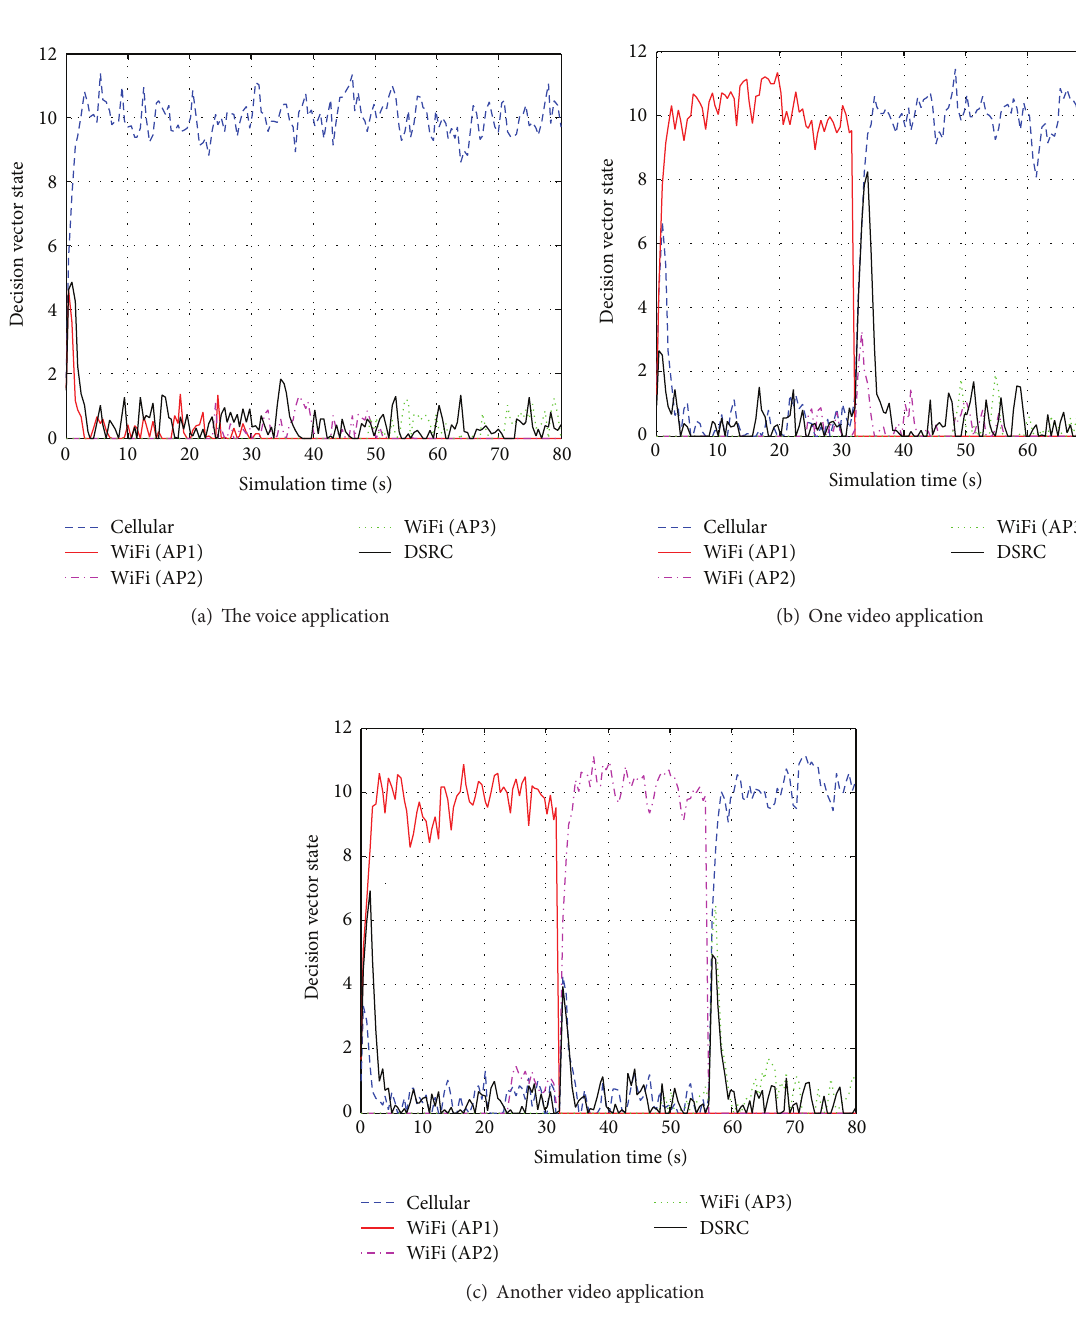
Figure 6: The variation of the decision vector states of the different